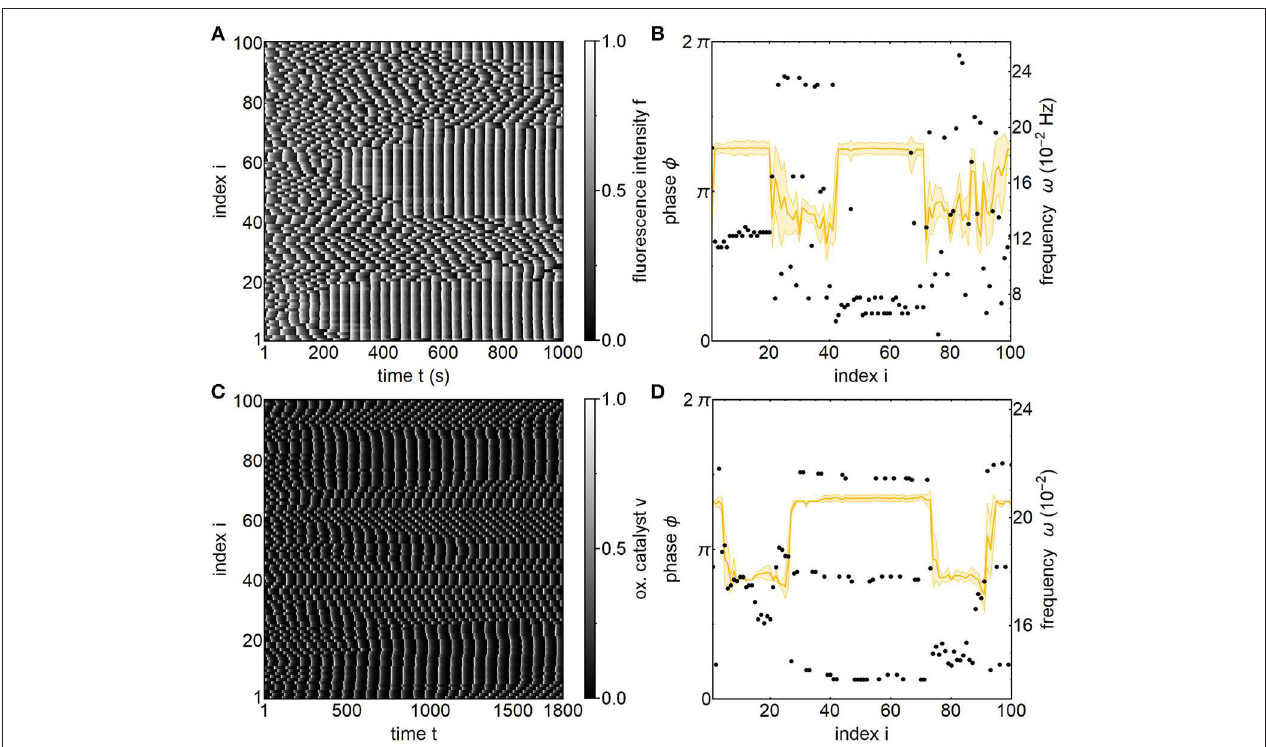
FIGURE 4 | Two-headed chimera state. (A) Experimental space-time plot of the fluorescence intensities of N = 100 nonlocally photo-coupled chemical oscillators exhibiting a two-headed chimera state. (B) Snapshot of instantaneous phases and time-averaged frequencies at time t = 586s revealing two in-phase synchronized and two noisy cluster domains. Parameters: K = 0.1, κ = 3.3, τ = 32s , T 0 = 86 ± 12s, [H 2 SO 4 ] 0 = 0.77M , [NaBrO 3 ] 0 = 0.51M , [malonic acid] 0 = 0.16M , catalyst load: 2.5 × 10 − 5 mol Rudmbipy 3 3 + / g resin. (C) Numerical space-time plot of the oxidized catalyst v . (D) Snapshot of instantaneous phases and time-averaged frequencies at time t = 1,362 revealing two in-phase synchronized and two noisy cluster domains. Parameters: K = 2.98 × 10 − 4 , κ = 4, τ = 8.67. Other parameters as in Figure 1